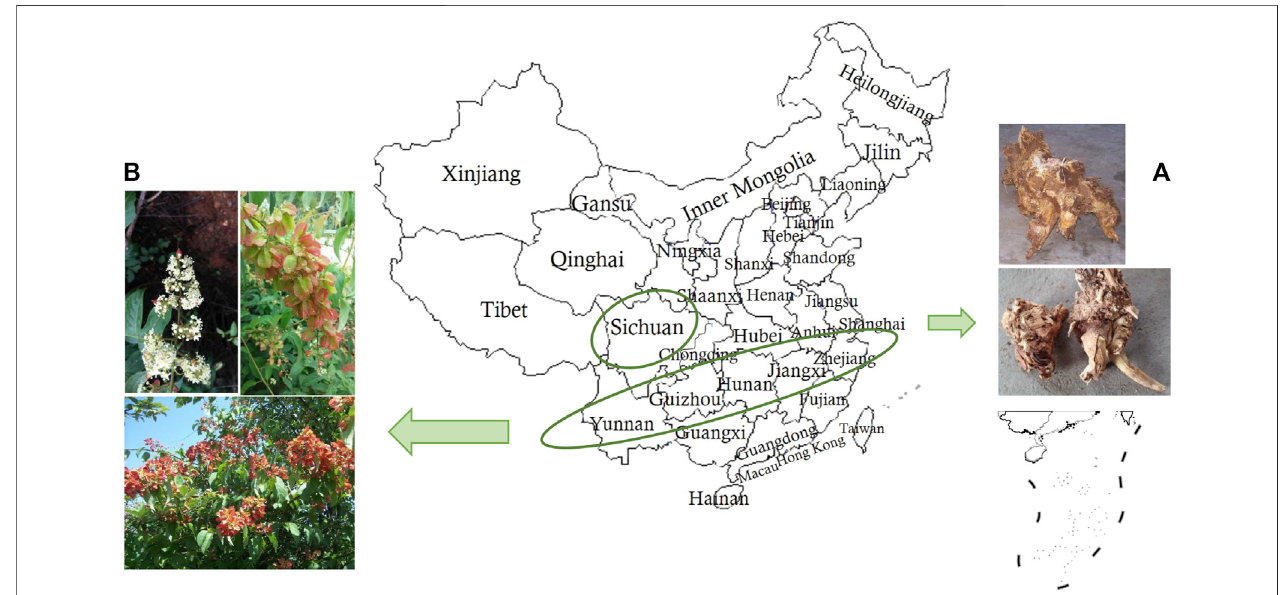
FIGURE 1 | Climatic and ecological adaptability distribution of THH in China. (A) Dried root bark of THH, (B) Aerial view of THH.